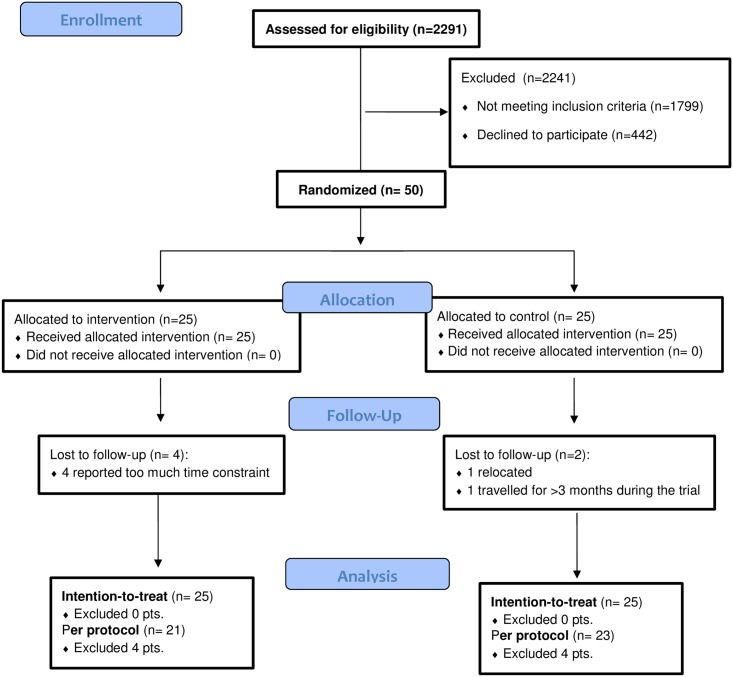
CONSORT flow diagram.